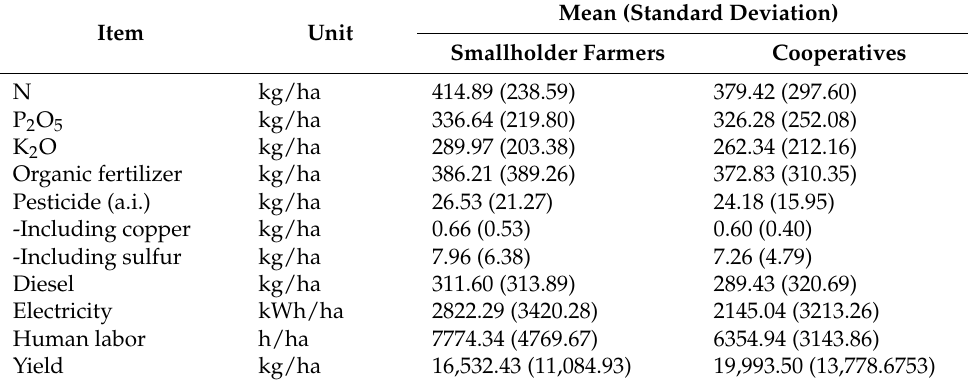
Table 2. Input/yield list for one average productive year of apple production in Qingcheng